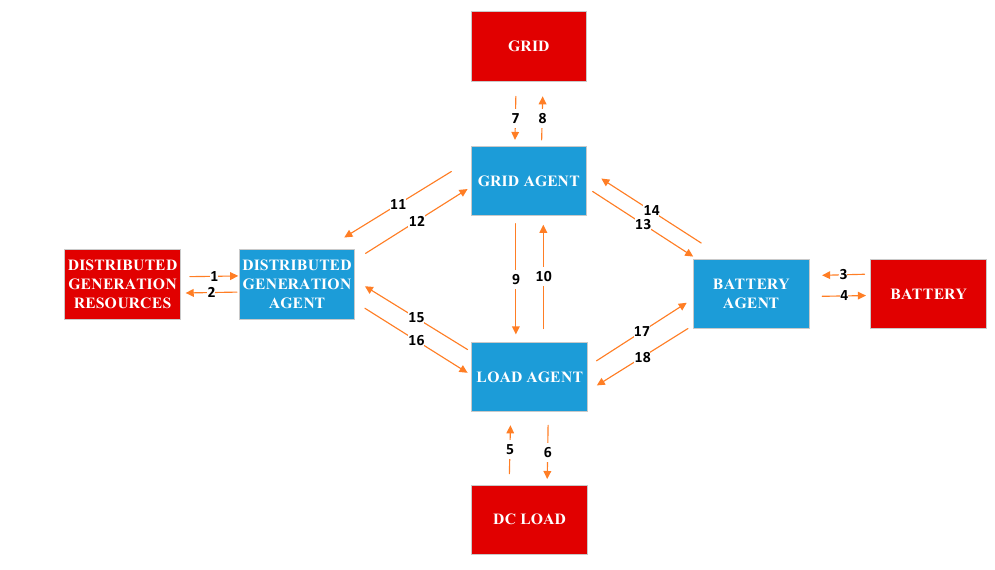
Figure 4. General overview of the proposed multi-agent-based control for the microgrid. Table 6. Communication and coordination of agents .